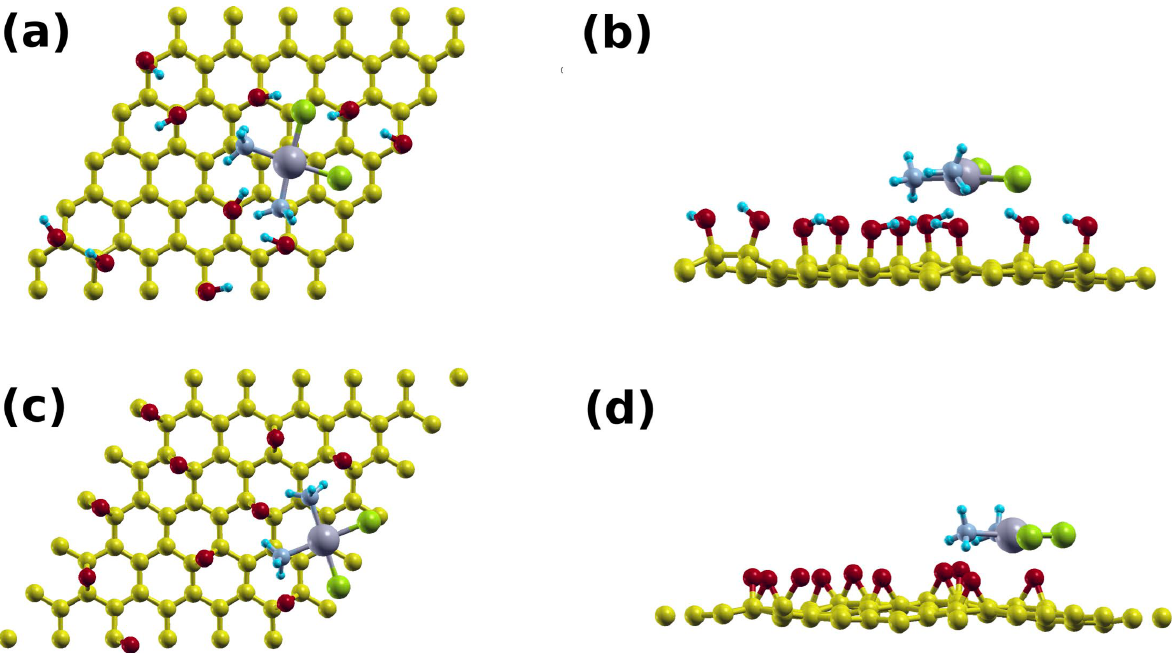
Figure 5. Supercell of the: ( a ) top; and ( b ) side view of the cisplatin-GO1 system, and (c) top and ( d ) side views of the cisplatin-GO2 system. ( d ) side views of the cisplatin-GO2